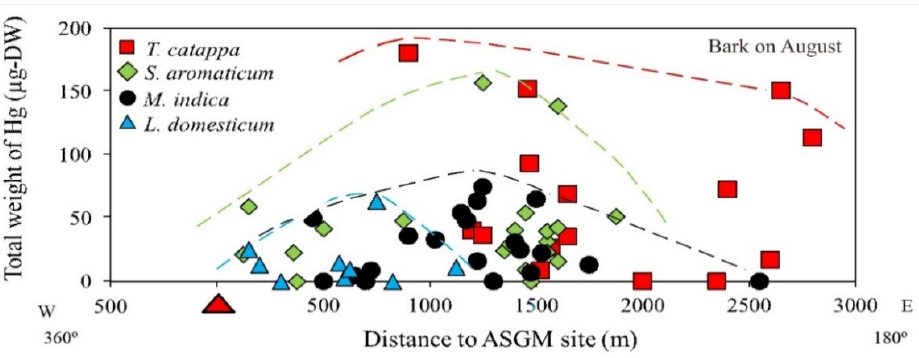
Figure 4. Total weight of Hg (THg) in the bark of various tree species.